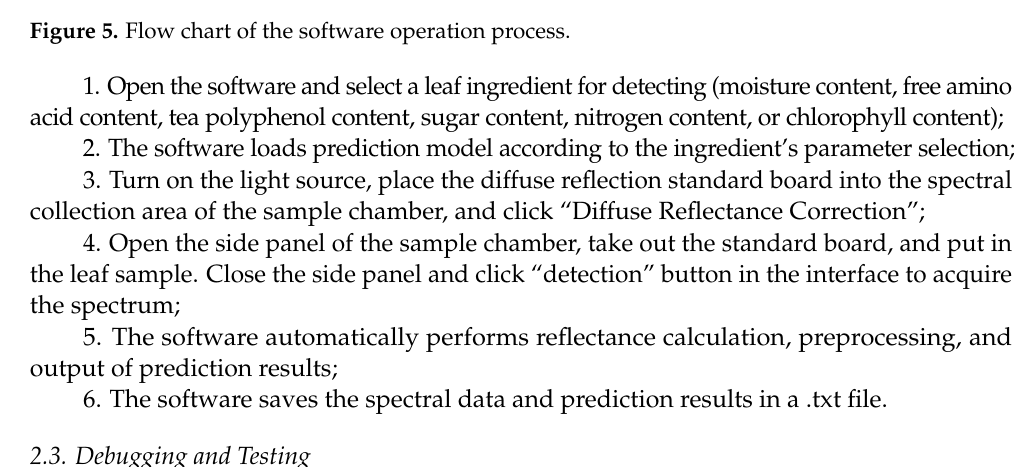
Table 2. Result of debugging and testing experiment.